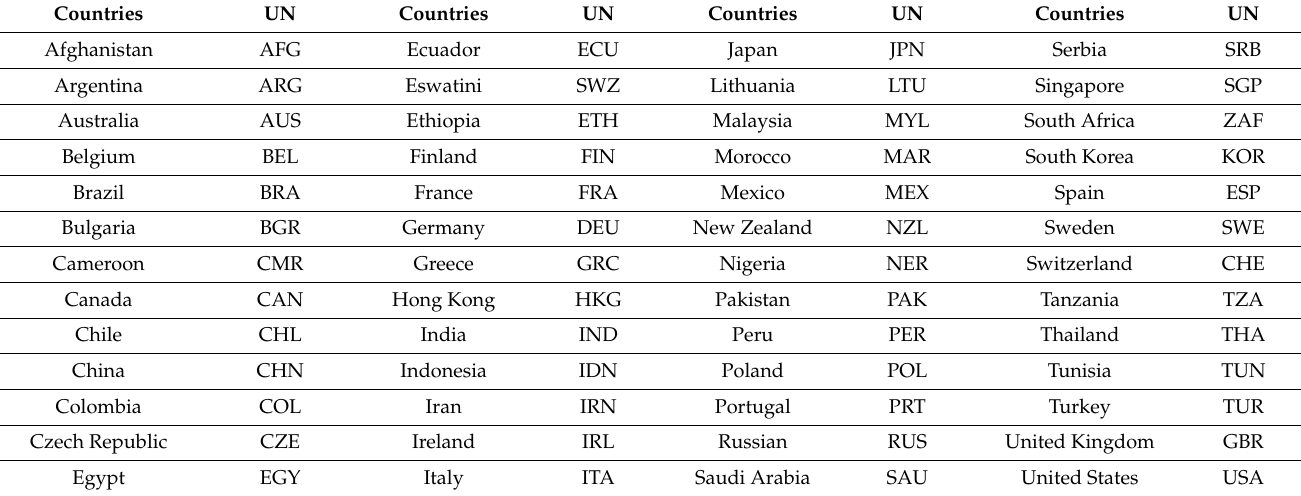
Table 1. Abbreviated country names according to the United